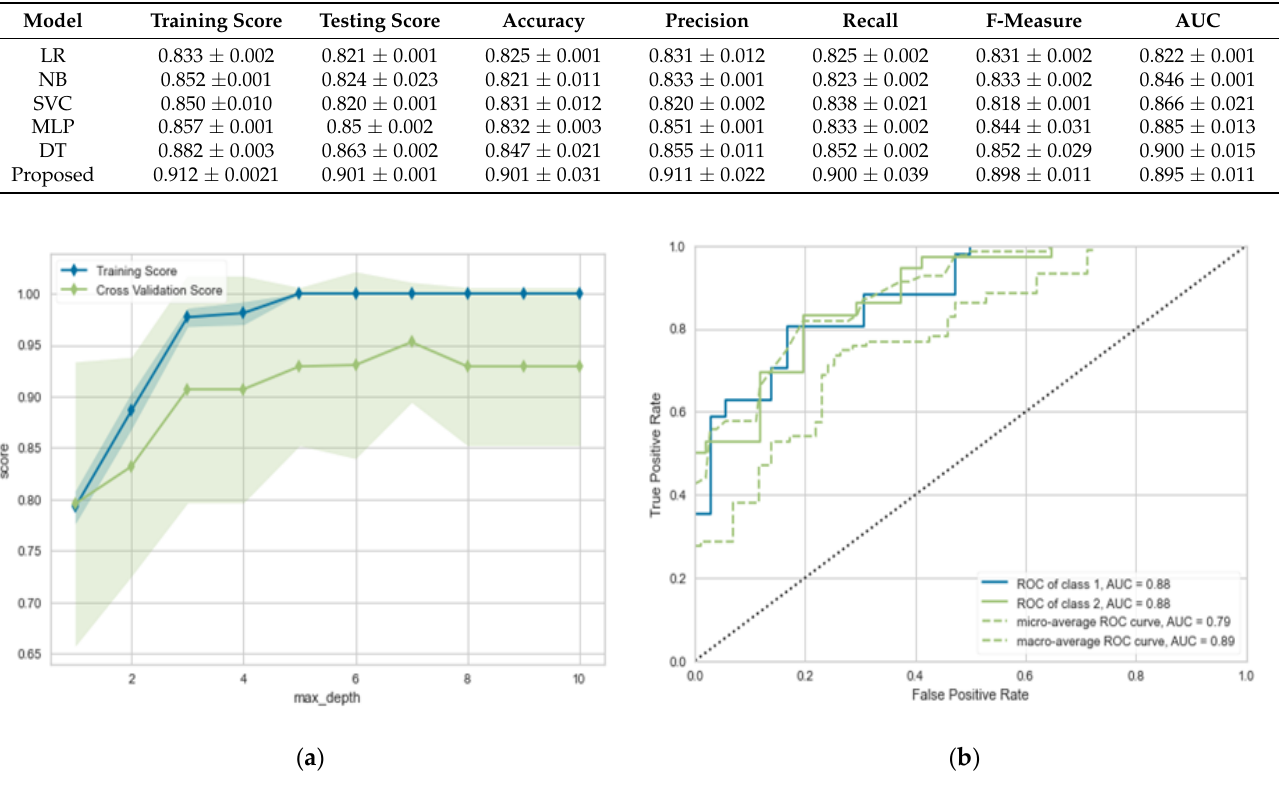
Table 4. Results of the prognosis model after 6